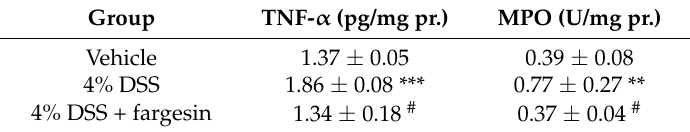
Table 1. Effects of fargesin on TNF- α level and MPO activity in colitis mice.